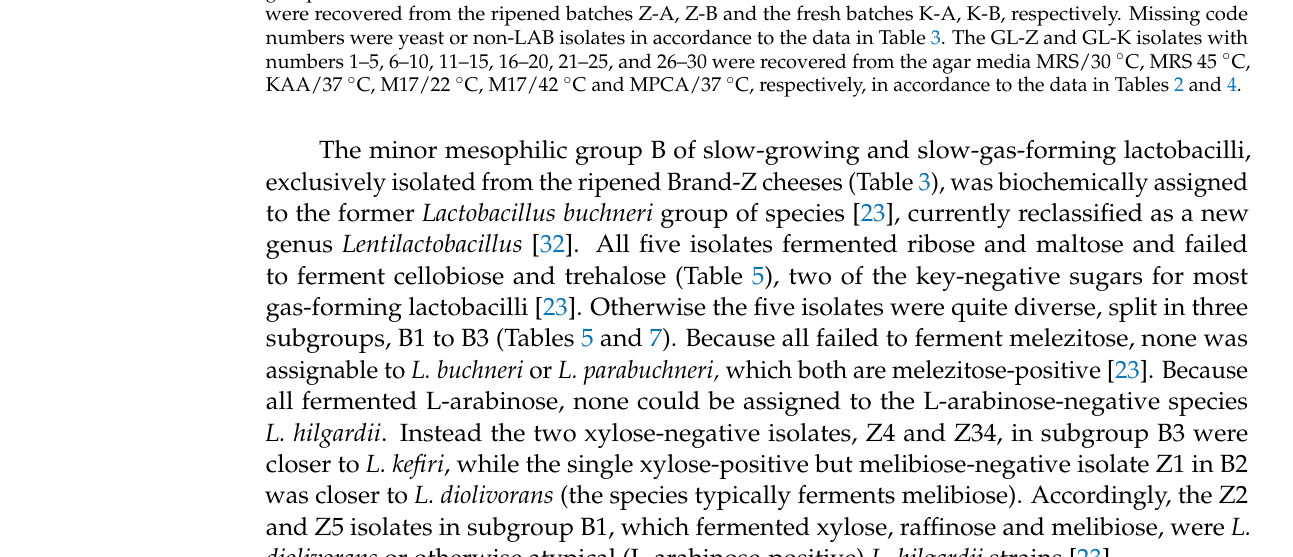
Biochemical Subgroup in Table 5 or Table